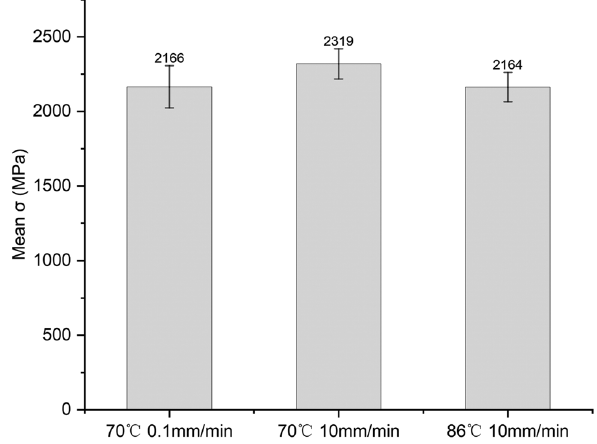
Table 1: Values of k j and τ j